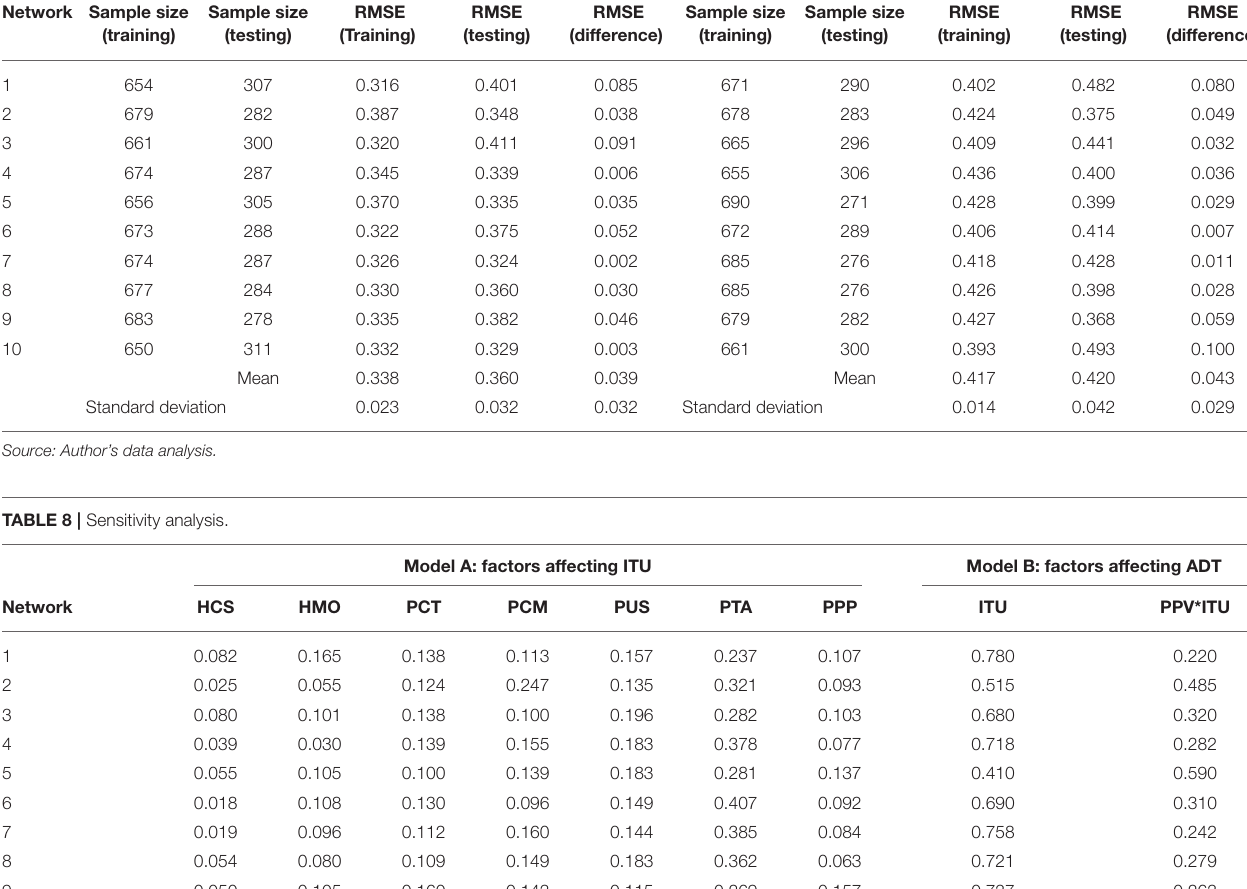
TABLE 7 | RMSE values of artificial neural networks ( N = 961). Model A: factors affecting the ITU Model B: factors affecting the adoption of eDoctor Apps Network Sample size (training)